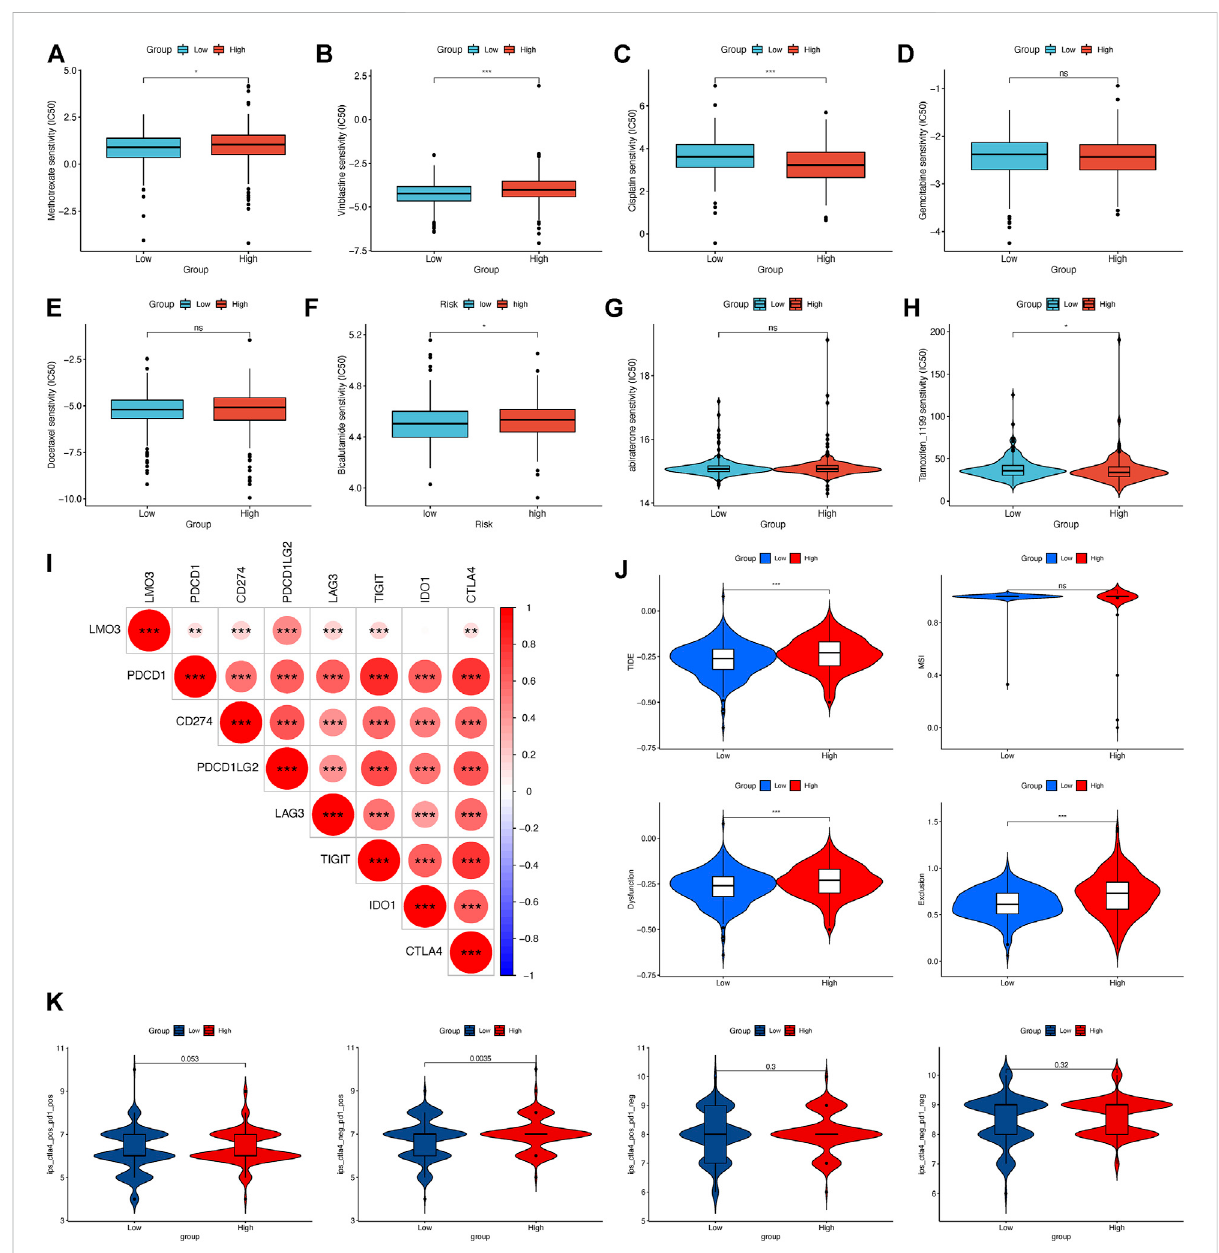
FIGURE 7 Relationship between LMO3 expression and drug sensitivity. (A – H) IC50 of LMO3 expression-de fi ned subgroups to drugs, including (A) methotrexate, (B) vinblastine, (C) cisplatin, (D) gemcitabine, (E) docetaxel, (F) bicalutamide, (G) abiraterone, and (H) tamoxifen. (I)